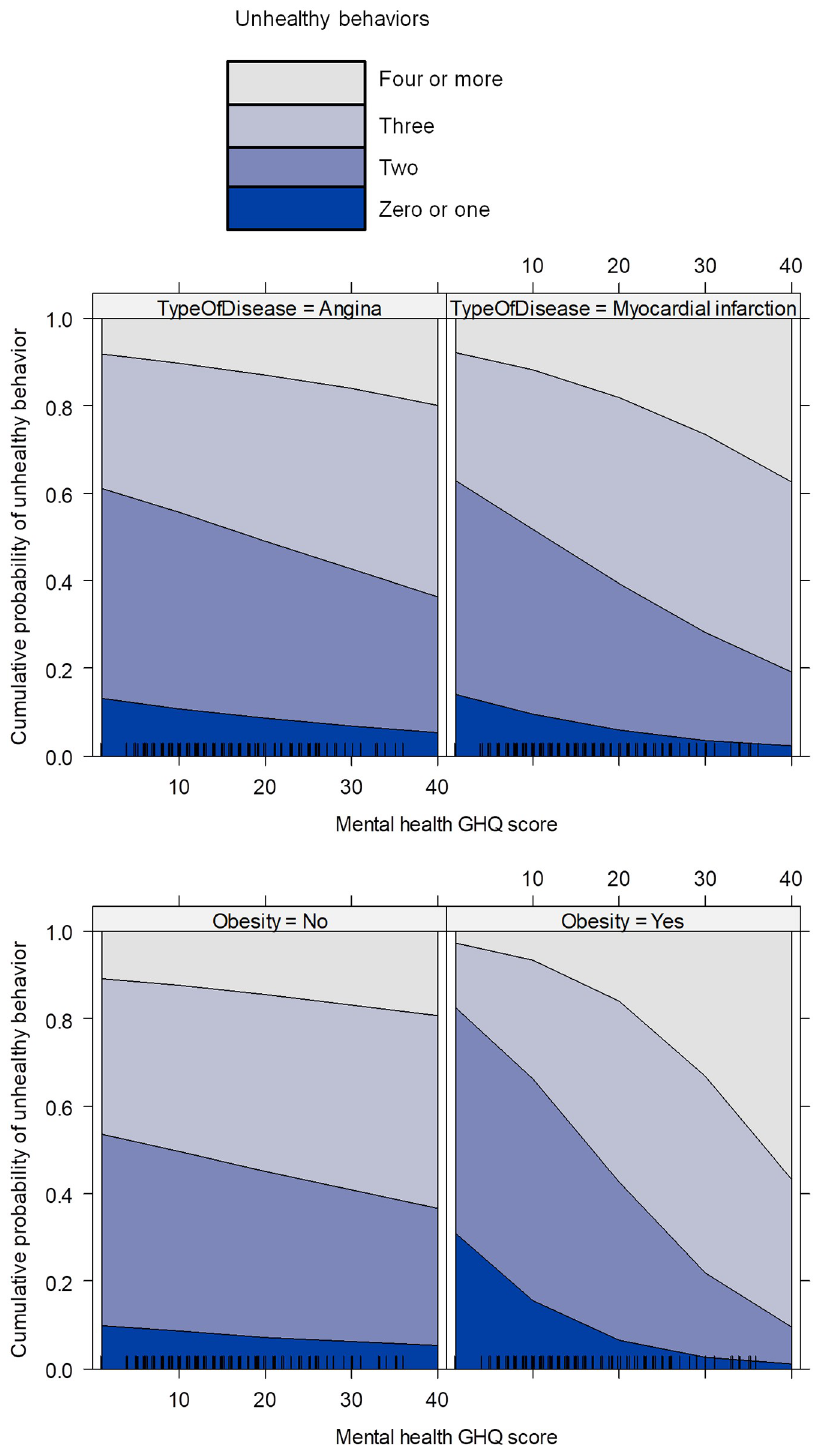
Fig 1. Relationship between mental health and the cumulative predicted probability of unhealthy behavior for each category derived from the multiple ordinal regression model, as a function of type of disease and the presence of